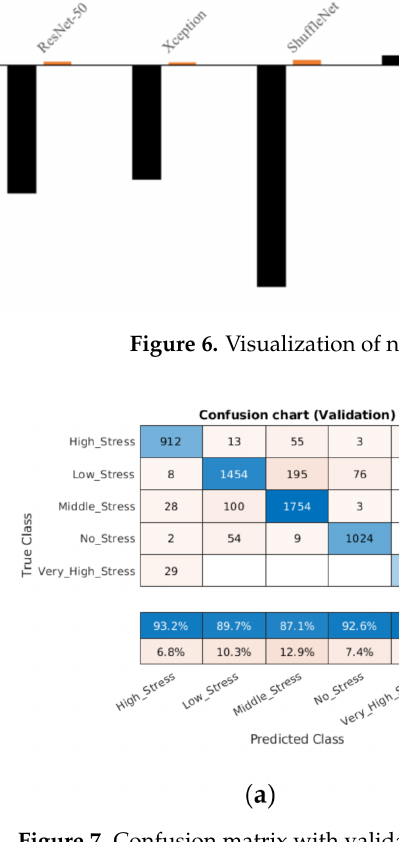
Figure 7. Confusion matrix with validation ( a ) and test ( b ) datasets.